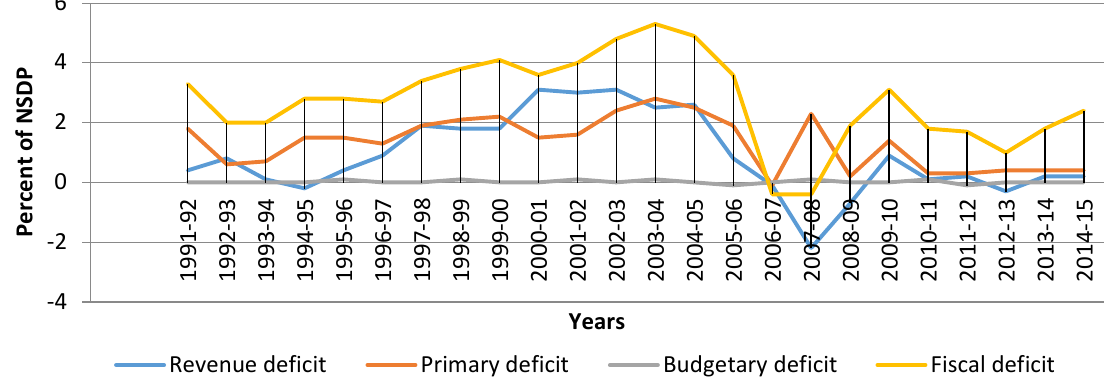
Figure 2. Revenue, primary, budgetary and fiscal deficits from liberalization era